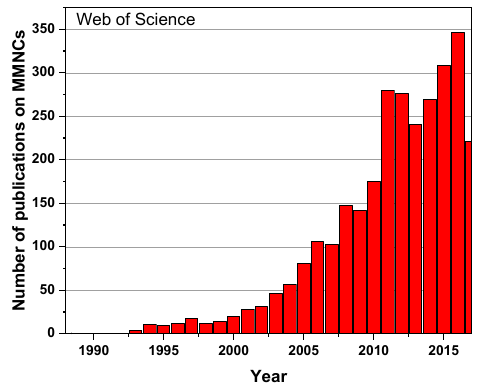
Figure 1. Number of publications on metal matrix nanocomposites (MMNCs) in Web of Science.